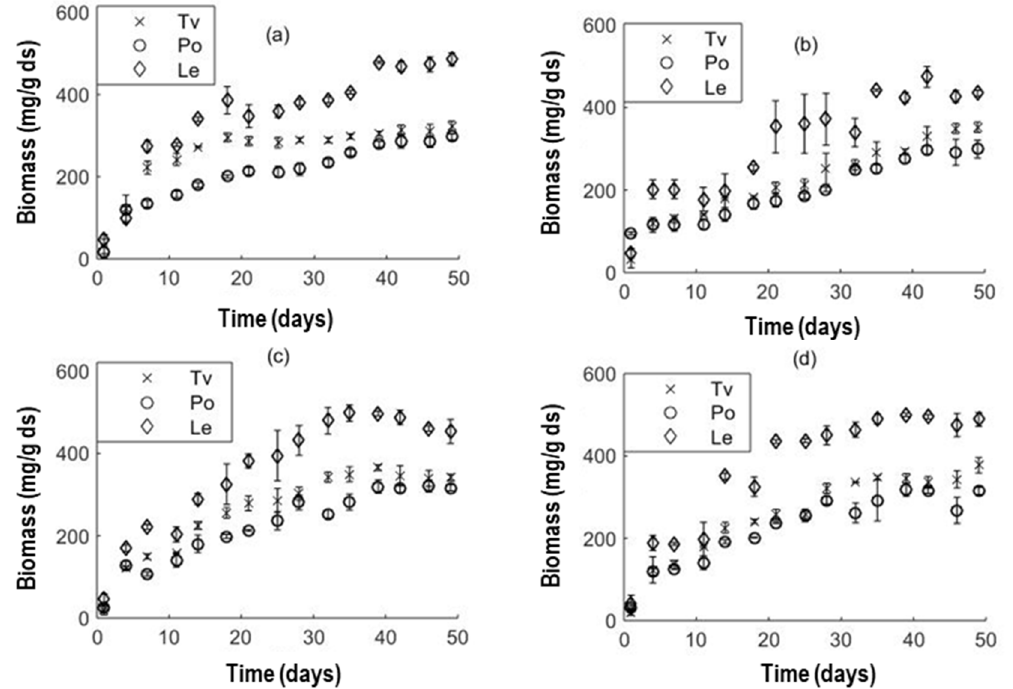
Figure 1. Biomass production of T. versicolor (Tv), P. ostreatus (Po), and L. edodes (Le) grown on different solid media based on oak sawdust, coconut fiber, coffee husks, corn bran, and soybean oil for 49 cultivation days under solid-state fermentation (SSF) conditions. ( a ) Biomass growth on F2 medium. ( b ) Biomass growth on F4 medium. ( c ) Biomass growth on F10 medium. ( d ) Biomass growth on F11 medium. The formulation for each medium is deciphered in Table 1; ds: dry solid.